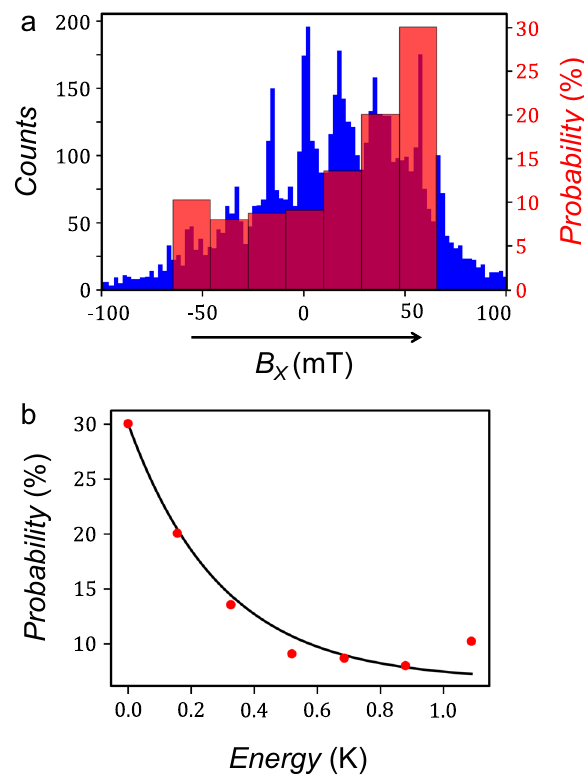
Fig. 5 Effective temperature of the nuclear spins. a Histogram of the electronic spins reversals position for 6000 magnetic sweeps. The fi eld was swept from negative to positive values only. b Interpolation of the seven renormalized populations by a Maxwell – Boltzmann distribution. The extracted effective temperature is T ≈ 290